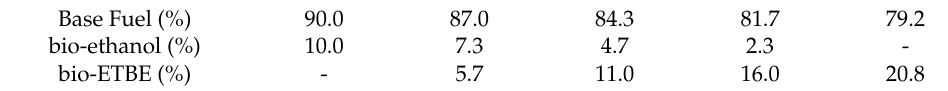
Table 4. Composition of blends of base fuels with